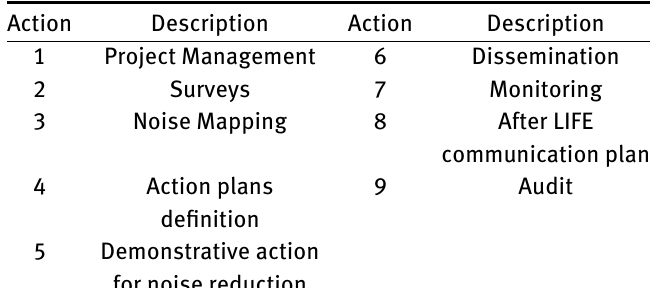
Table 1: Actions performed in NADIA